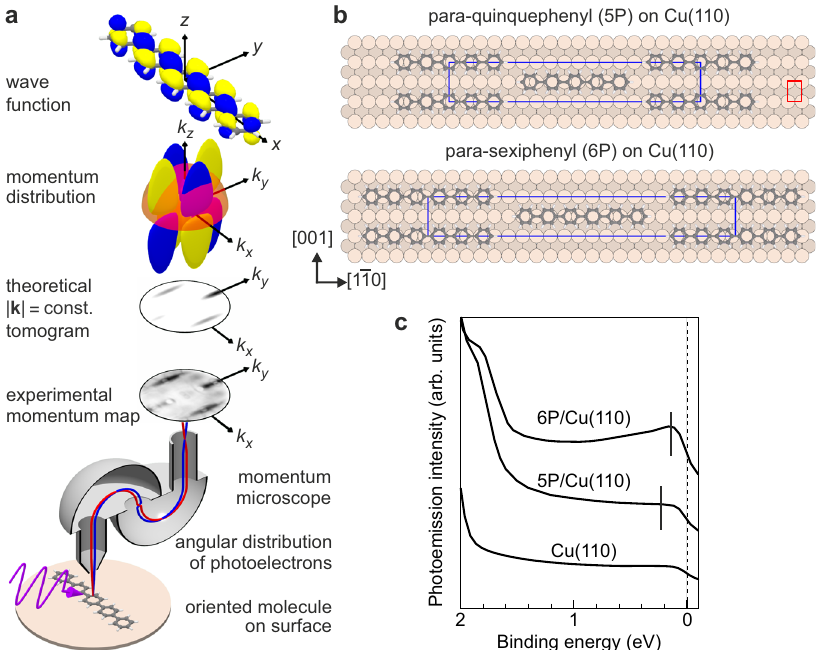
Fig. 1 | Photoemission orbital tomography. a Incoming photons (purple) excite photoelectrons from an ordered molecular layer. Their angular distribution is collected by the momentum microscope, which here is composed of two hemi- spherical electron analysers. The momentum microscope yields an energy- fi ltered two-dimensional k ∥ -spaceimageofthephotoemissionintensity.Thisexperimental momentum map corresponds to tomograms of the orbital's momentum distribu- tion, obtained by a hemispherical cut (Ewald sphere) through the three- dimensionalFouriertransformof the orbital'swave function.The size ofthe Ewald